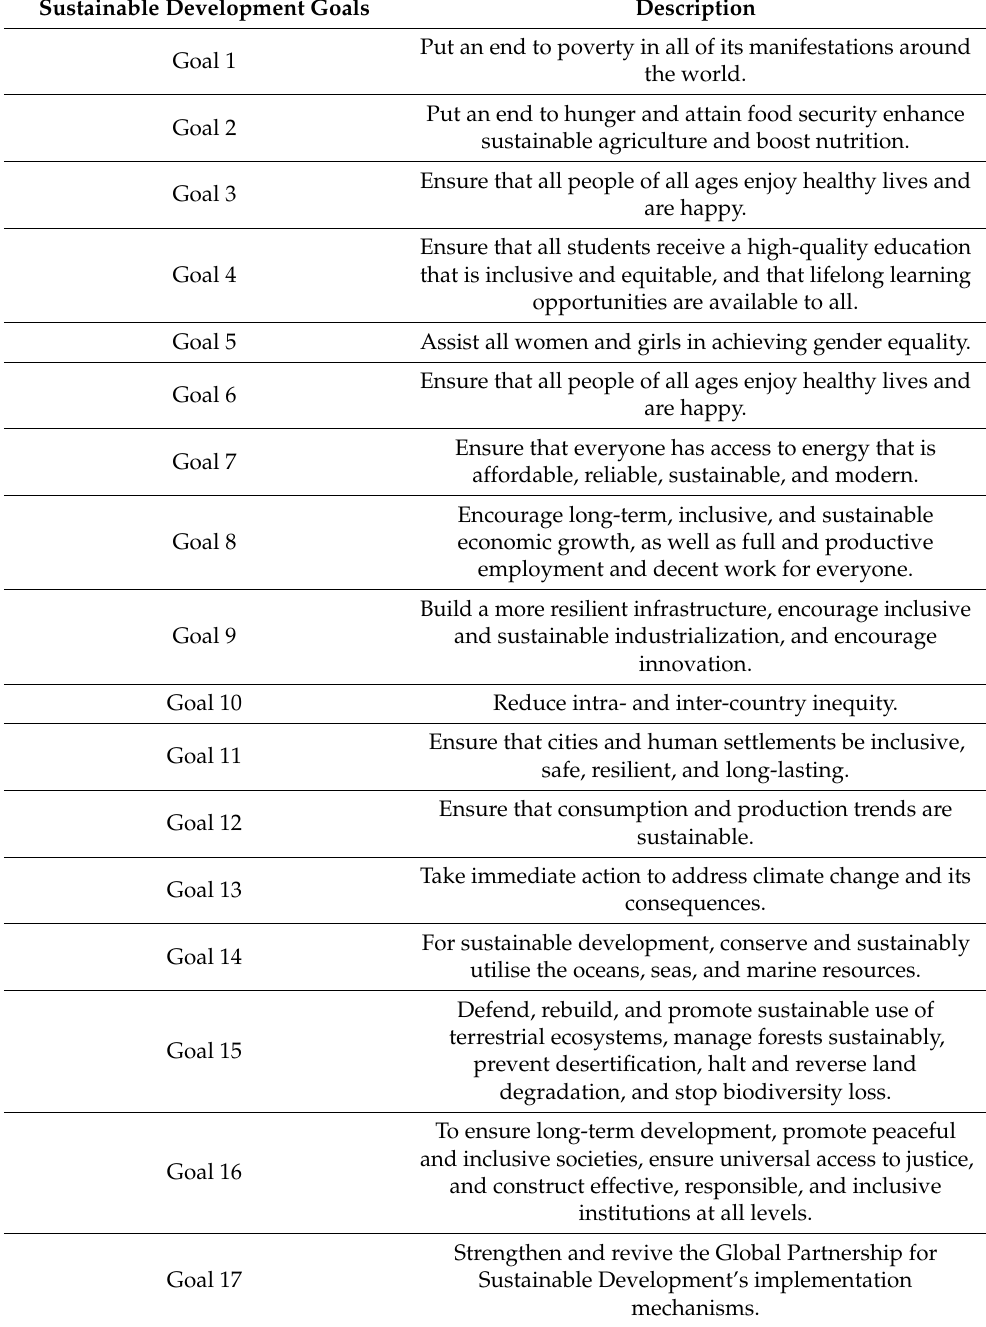
Table 1. Sustainable development